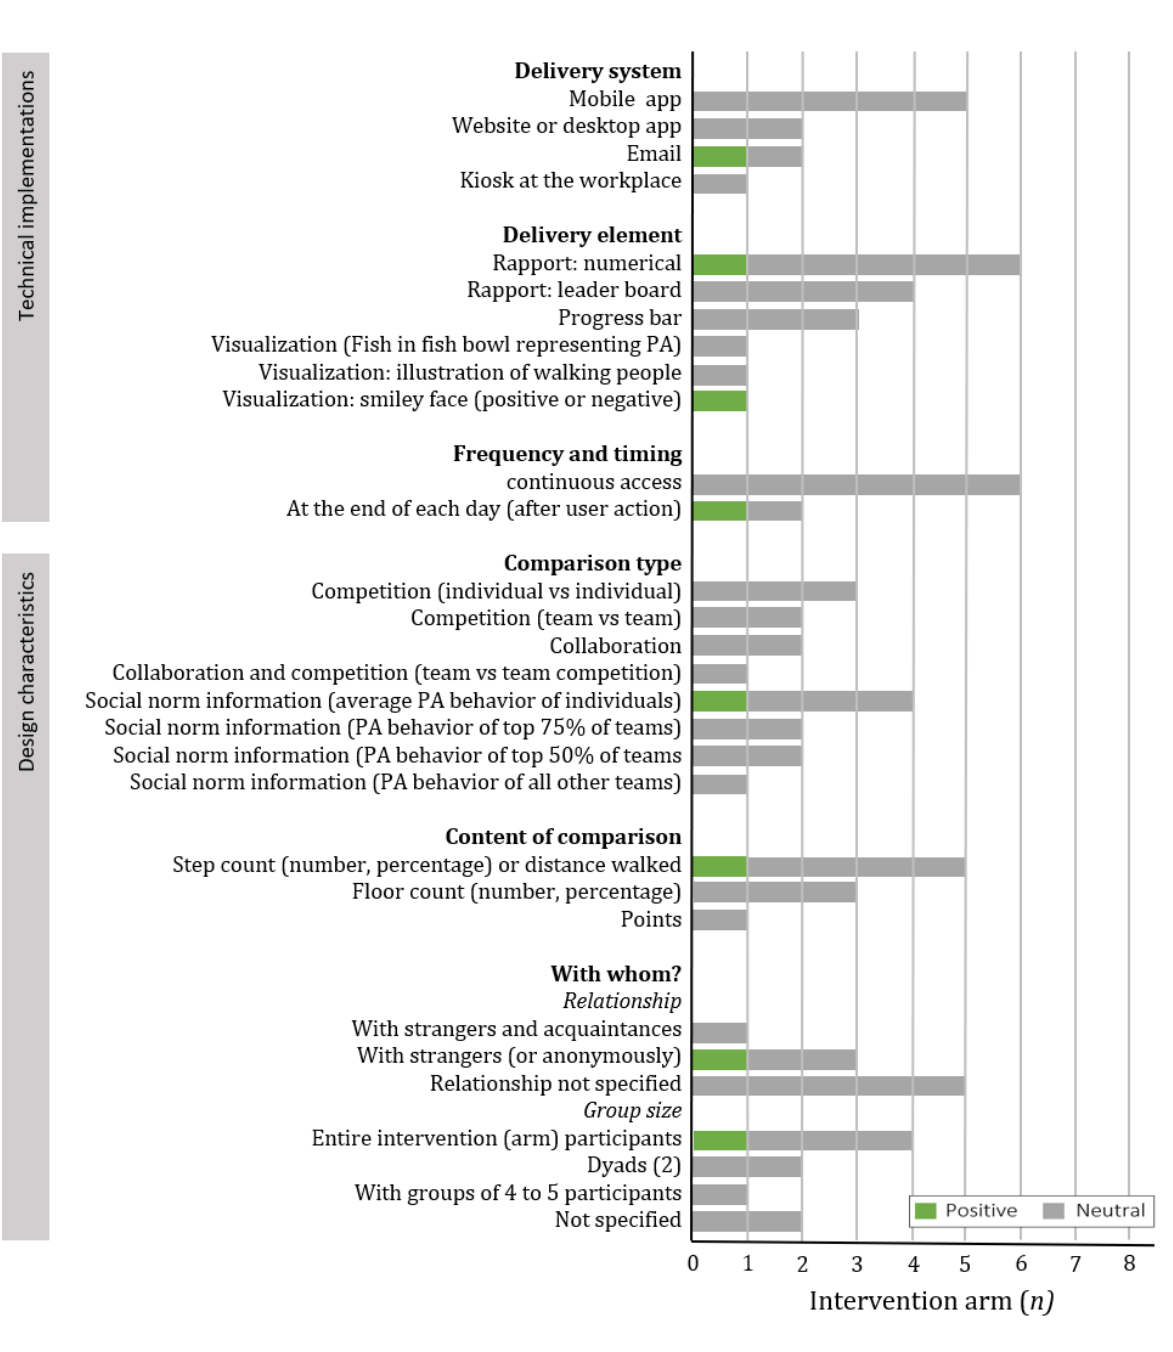
Figure 5. The effectiveness of the technical implementations and design characteristics of social comparison compared with receiving no comparison in 9 intervention arms (6 different studies). PA: physical